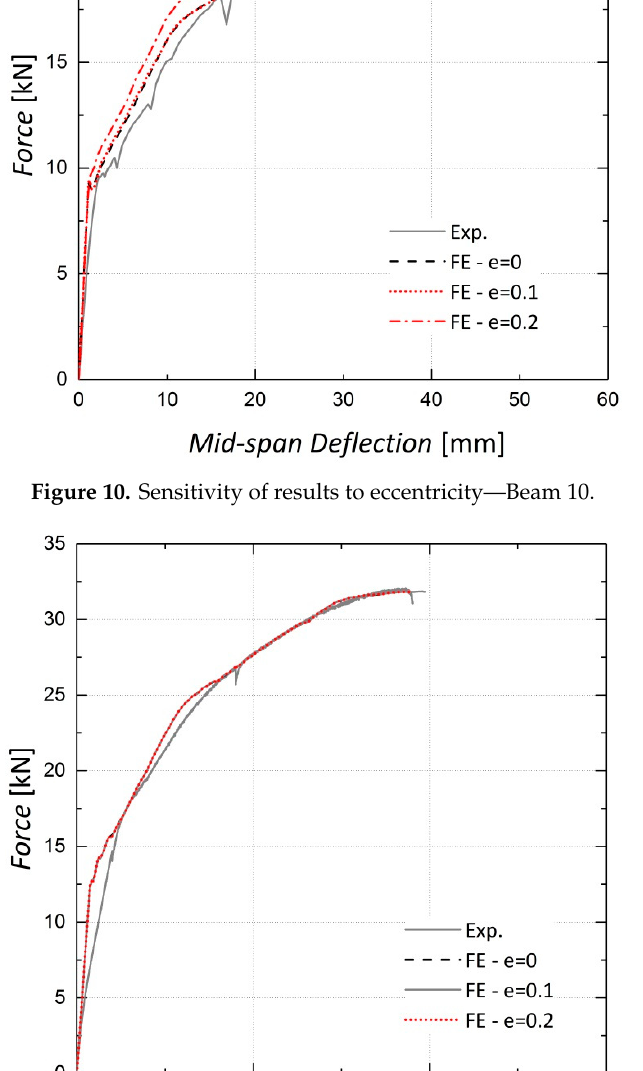
Figure 11. Sensitivity of results to eccentricity—Beam 11.